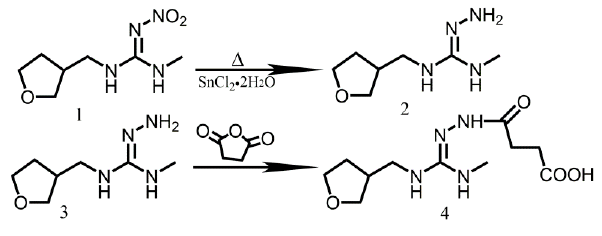
Figure 4. Synthesis route of antigen.